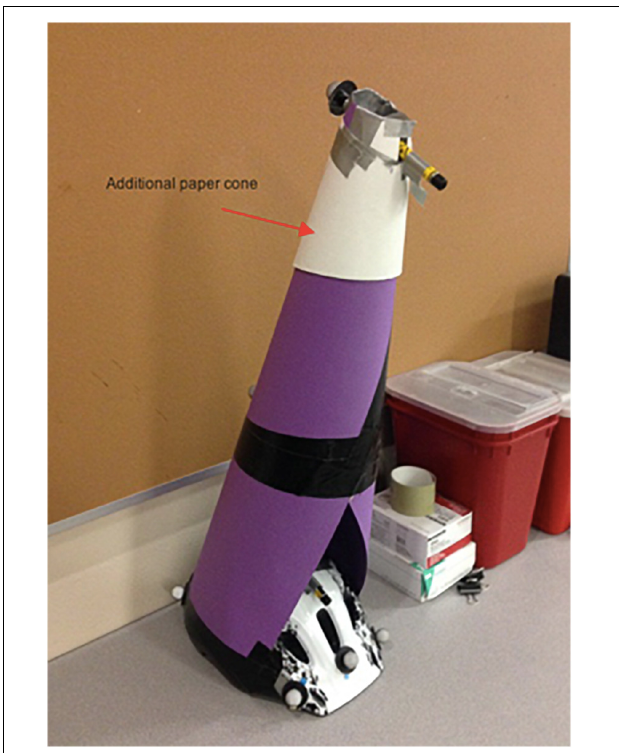
FIGURE 4 | Laser-cone apparatus used in Experiment 2.